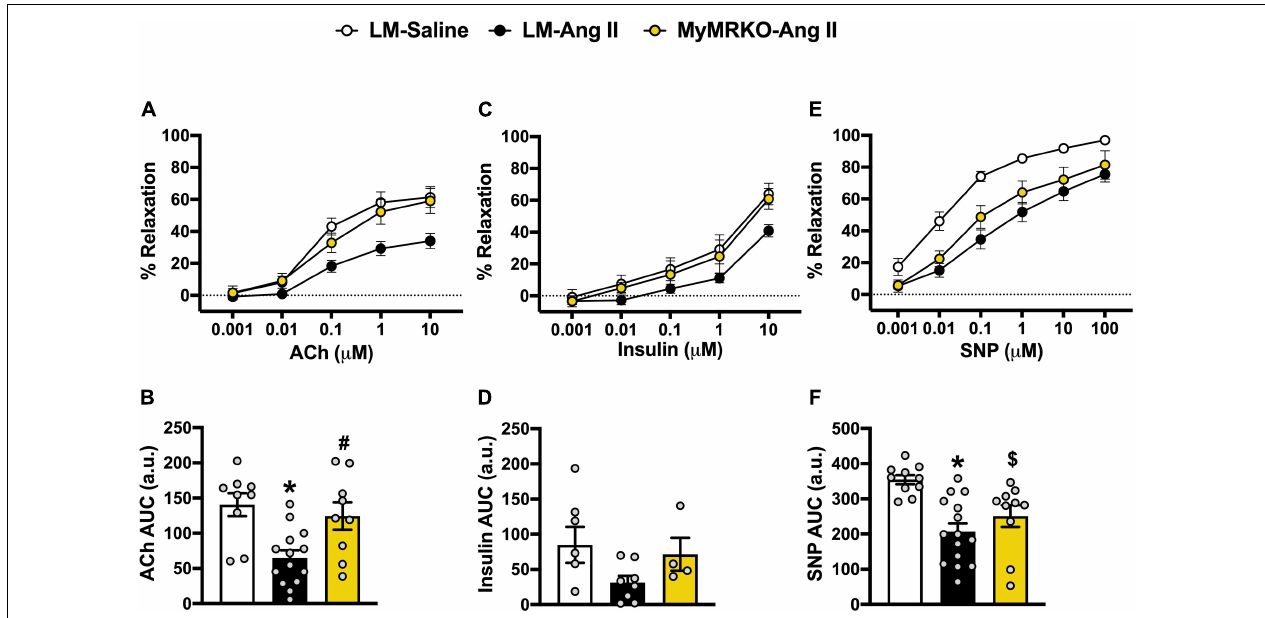
FIGURE 2 | Deletion of myeloid cell MR improves endothelial function in Ang II-infused mice. Aortic vasomotor responses to acetylcholine (ACh) [ (A) response curve, (B) area under the curve (AUC)], insulin (C,D) , and sodium nitroprusside (SNP) (E,F) . * p ≤ 0.05 LM-Ang II vs. LM-Saline; # p ≤ 0.05 LM-Ang II vs. MyMRKO-Ang